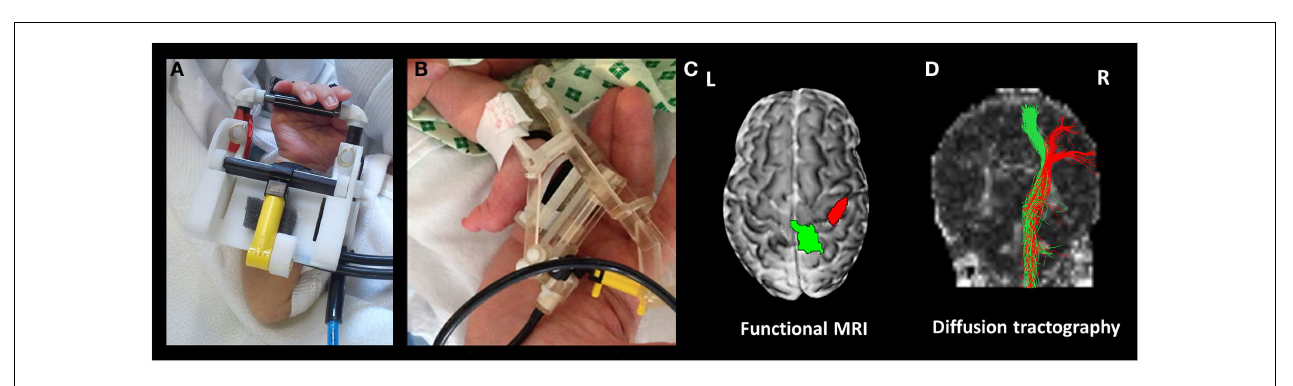
preterm infant at 35 + 4weeks post-menstrual age, this approach can then be used to identify localized clusters of functional response (C) using fMRI (green cluster identified with passive movement of the left ankle, and red following passive movement of the left wrist), and their underlying structural connections can be delineated using diffusion tractography (D)